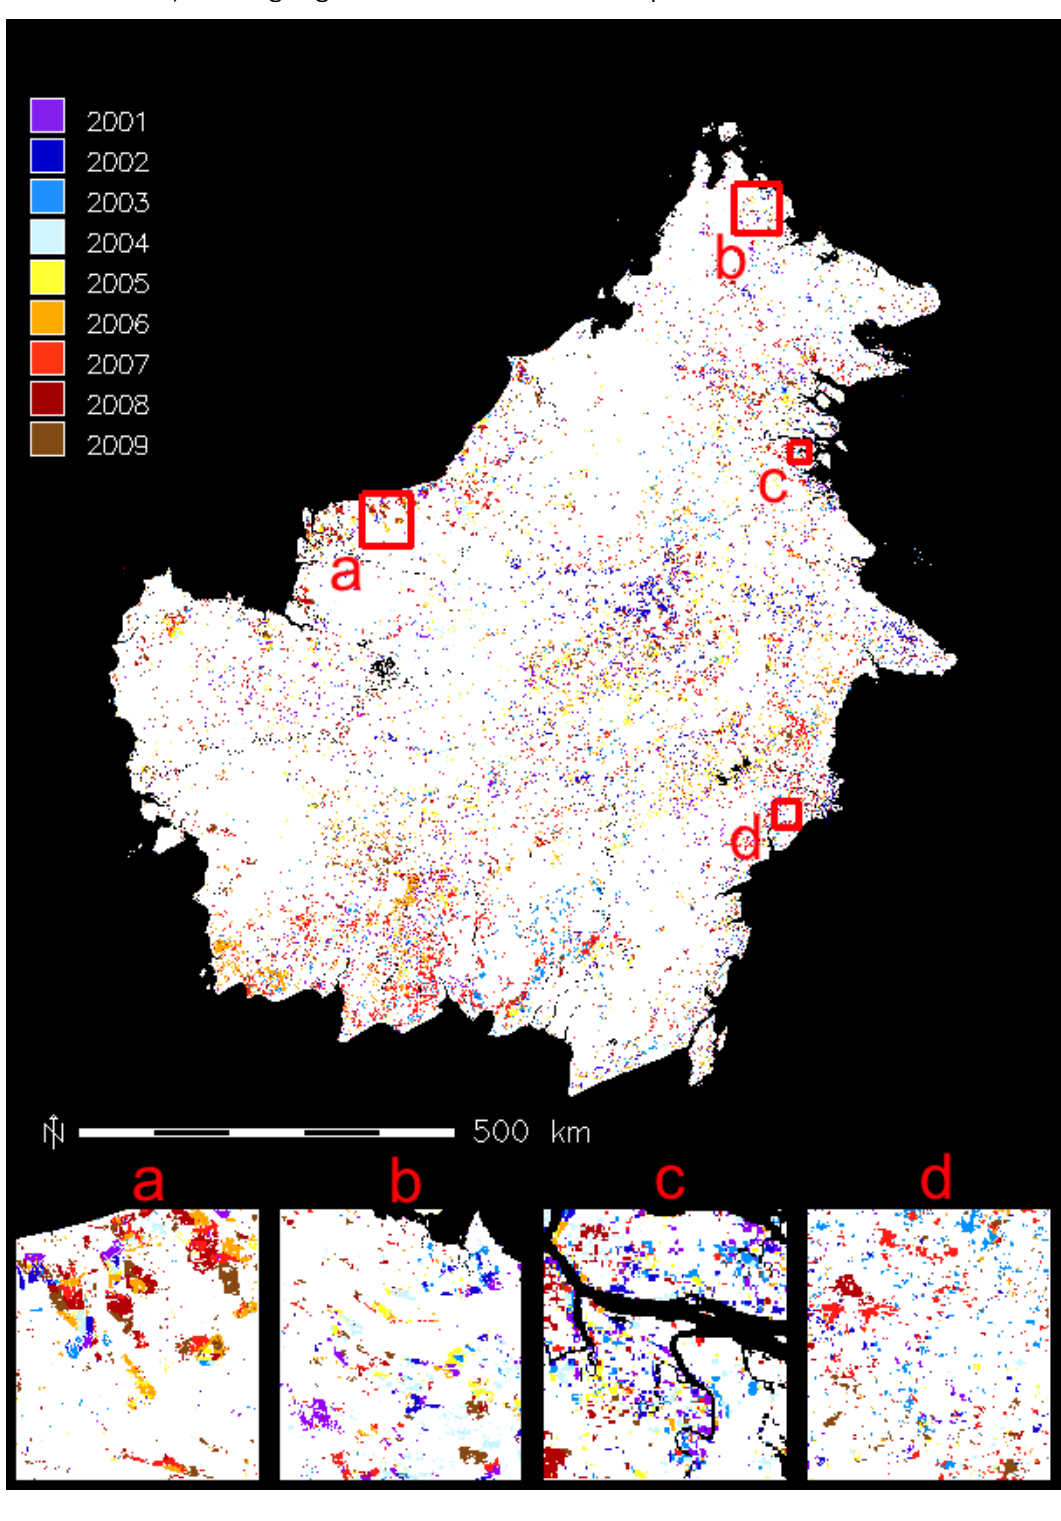
Figure 9. Yearly deforestation hotspots detected in between the year 2001 and the year 2009 in Borneo, with highlighted areas shown in lower